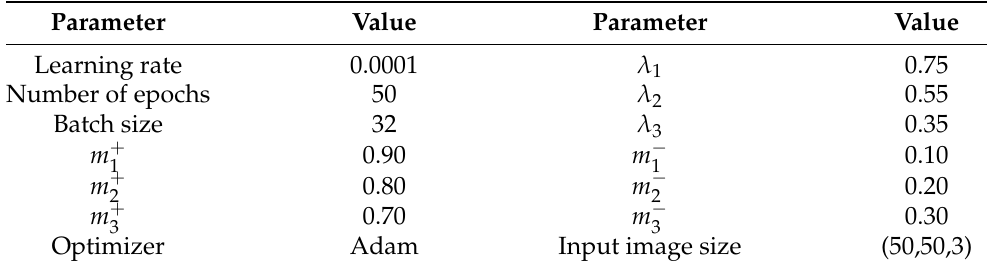
Table 2. Hyper parameters and their corresponding